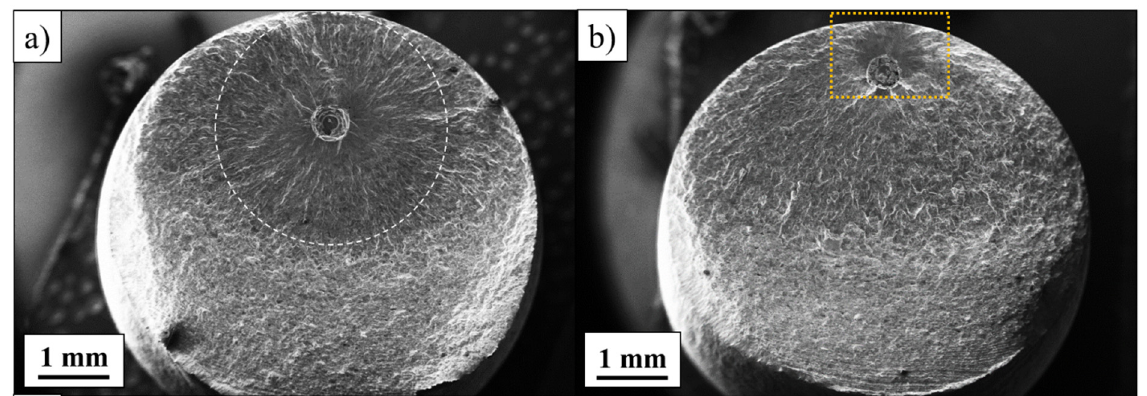
Figure 10. Fracture surfaces of two samples (deterministic defects) ( a ) defect positioned at half the radius and ( b ) defect positioned at the edge of the specimen at a distance equal to the diameter of the defect [13].